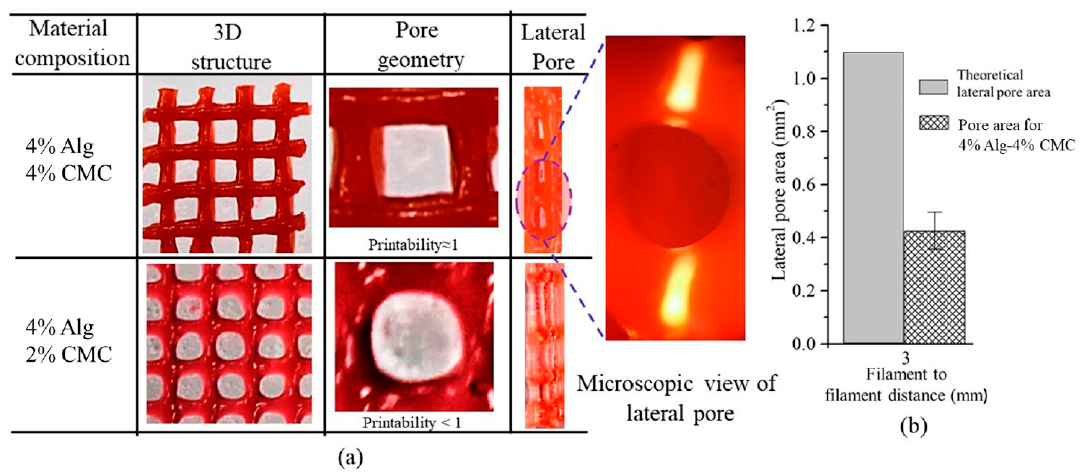
Figure 7. ( a ) Qualitative; and ( b ) quantitative tests for lateral pores [119].